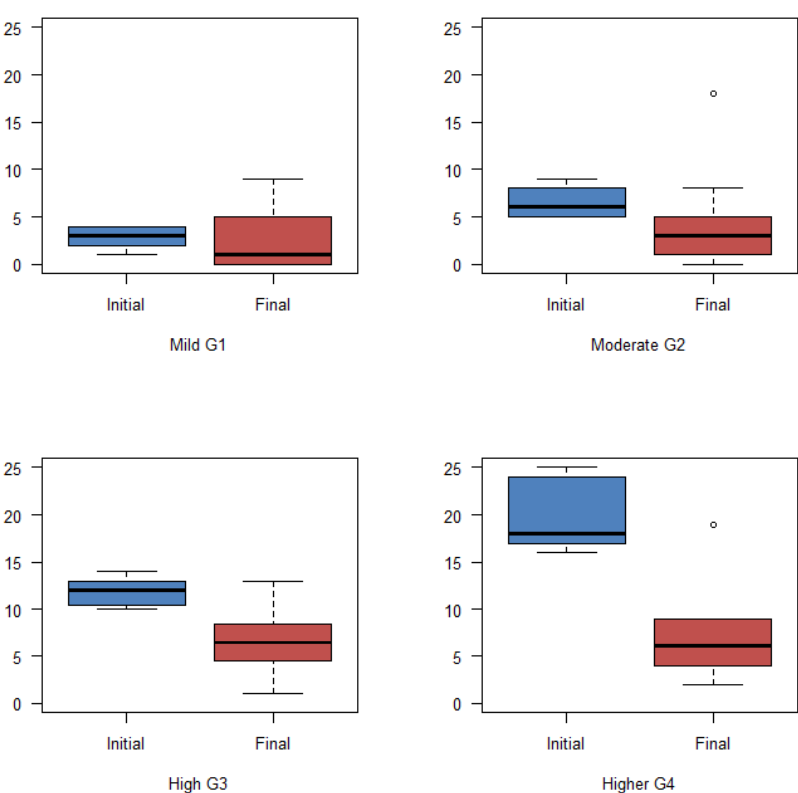
Figure 2. Personal health questionnaires (PHQ–9) at the beginning and end of therapy. Results by groups with different degrees of depression: Mild G1 (PHQ−9 < 5, n = 10); Moderate G2 (PHQ−9 ≥ 5 and < 10, n = 17); Moderate High G3 (PHQ−9 ≥ 10 and < 15, n = 8); Higher G4 (PHQ−9 ≥ 15, n = 9). Table 3. Paired simple test and Wilcoxon test. Groups with different degrees of depression: Mild G1 (PHQ−9 < 5); Moderate G2 (PHQ−9 ≥ 5 and < 10); Moderate High G3 (PHQ−9 ≥ 10 and < 15; Higher G4 (PHQ−9 ≥ 15). (a) Wilcoxon test.